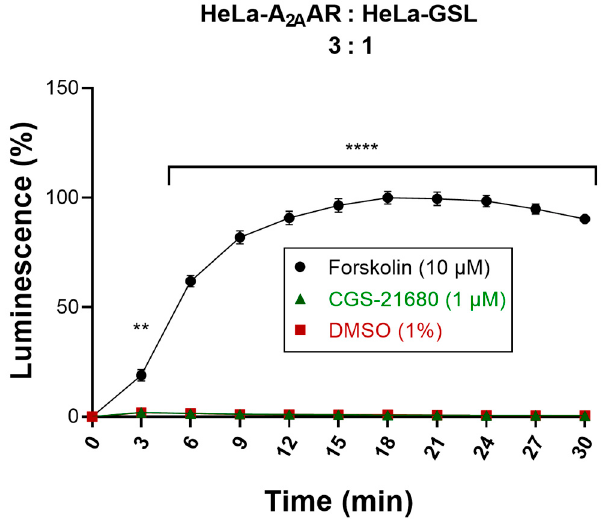
Figure 7. Evaluation of cocultured donor and biosensor cells lacking Cx43 GJs. Activation of cocultures of Cx43 ‐ deficient donor and biosensor cells by the selective A 2A AR agonist CGS ‐ 21680. Forskolin (10 μ M) was used as a positive control and DMSO (1%) served as a negative control. Data are normalized to the maximal effect of forskolin (100%). Data represent means ± SEM of three individual experiments performed in duplicates. Statistical significance calculated with repeated measures 2 ‐ way ANOVA and Dunnet’s multiple comparisons test comparing treatments to control (DMSO, 1%). ** p < 0.01, **** p <